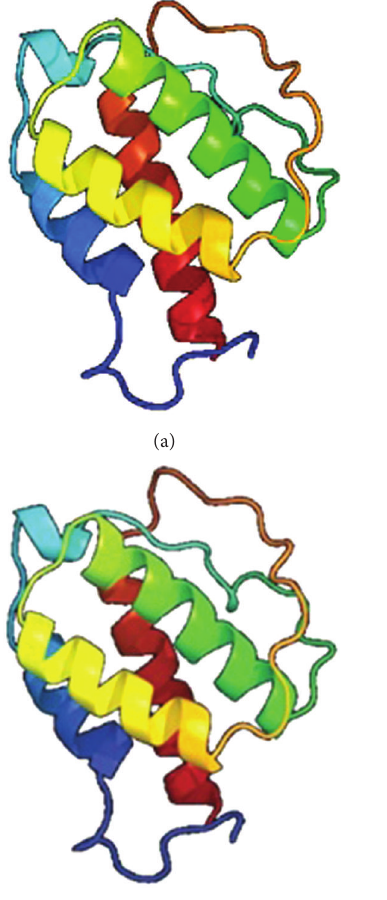
Figure4:Predicted3-Dstructureof(a)nilgaiand(b)Indianbuffalo IL-4